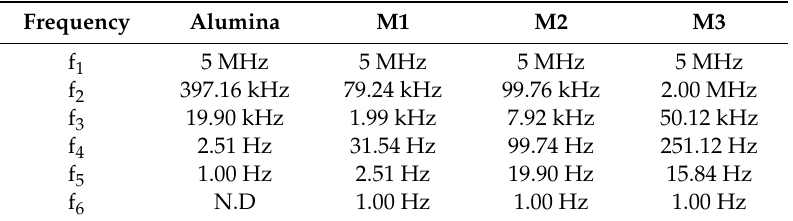
Table 4. Characteristic frequencies for the Nyquist diagram